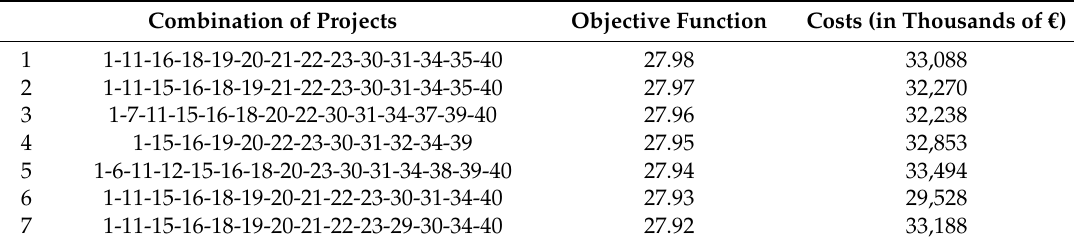
Table 5. List of the best combinations of projects. Combination of Projects Objective